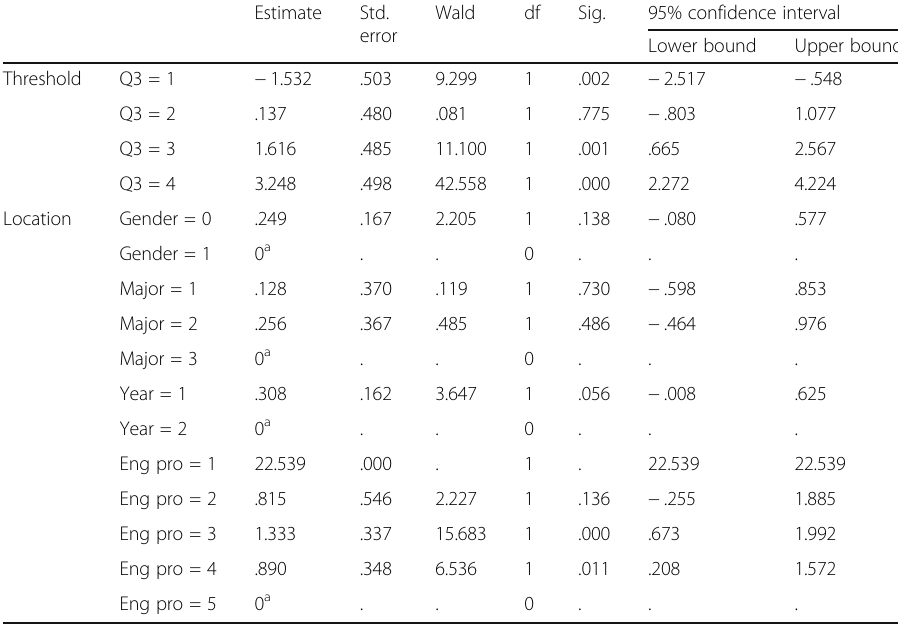
Table 6 Factors influencing students ’ English learning orientation Estimate Std. Wald df Sig. 95% confidence error